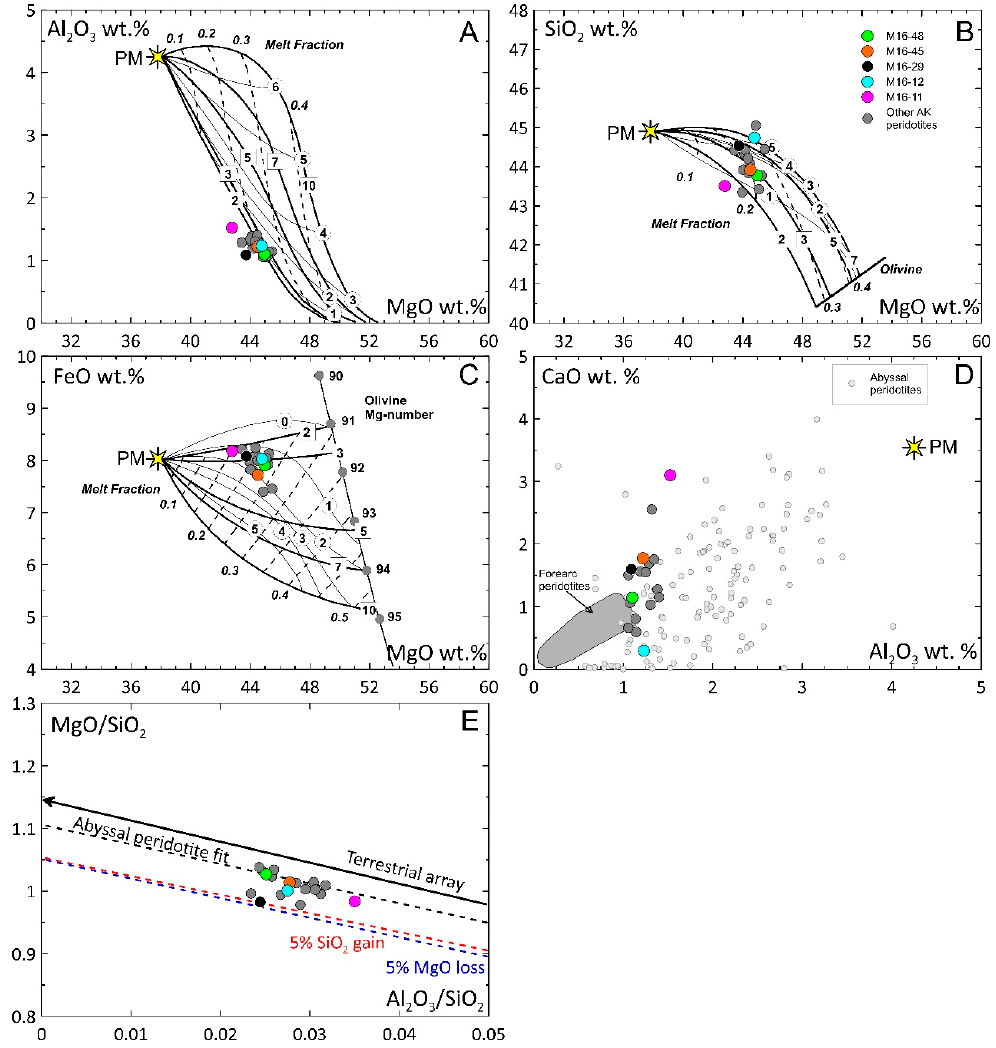
Figure 5. Variation diagrams for major oxides versus MgO ( A – D ) and MgO/SiO 2 and Al 2 O 3 /SiO 2 ratios ( E ) in the bulk-rock Alag Khadny peridotites. The model residue compositions formed by fractional melting are from [50], line labeled 90–95 in ( C ) shows mg-numbers of olivine; bold lines labeled with squares, initial melting pressures in GPa; light lines labeled with circles, final melting pressures; light dashed lines, melt fractions. Shaded area represents the composition field of forearc peridotites from [41], small gray dots—abyssal peridotites from [51], primitive mantle composition from [52]. Terrestrial array is from [53], abyssal peridotite fit line is from [54], and trends of SiO 2 gain and MgO loss are from [55].